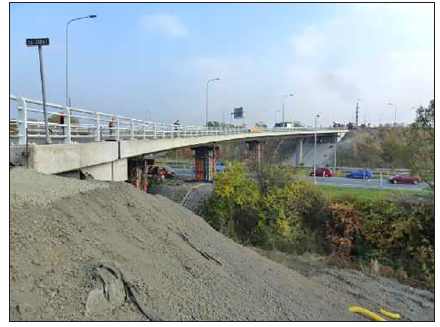
Figure 3. Bridge structures reg. No. 56-018a.1 (above) Figure 5. The excavated bridge transition